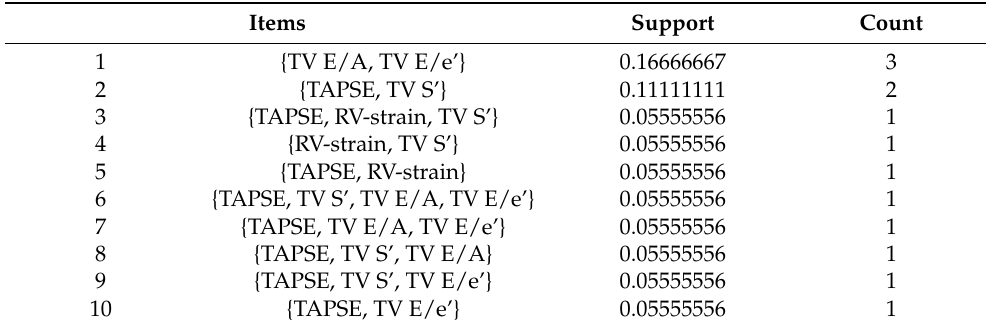
Table A2. First 10 itemsets (=combination of all pathological echocardiographic functional parame- ters) sorted by support and count. The most prevalent combination of pathological echocardiographic values was found for TV E/A + TV E/e’ and TAPSE + TV